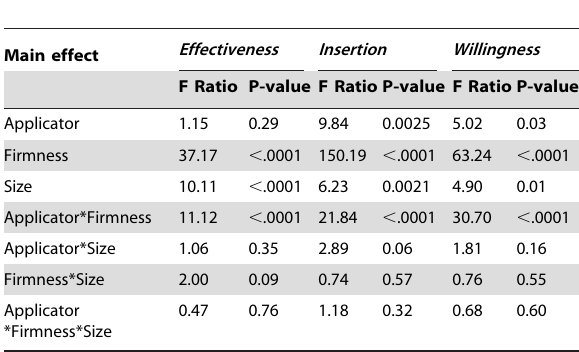
Table 2. Effects of Applicator, Firmness and Size on effectiveness, insertion and willingness